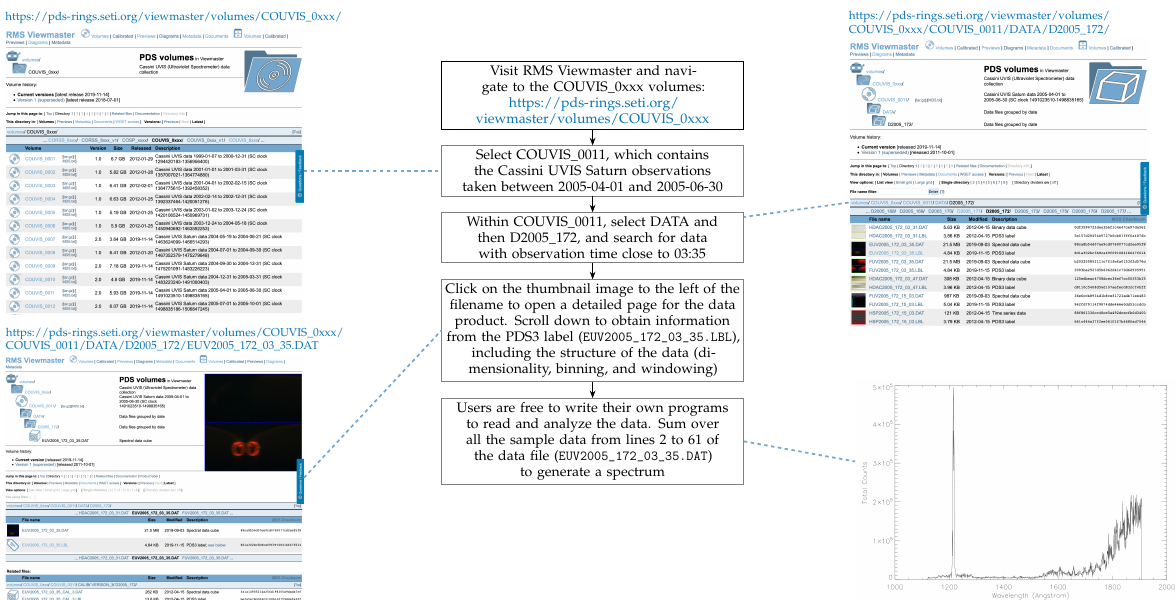
Figure 9. Step-by-step instructions on how to find and obtain UVIS data from the PDS via RMS Viewmaster for an observation of Saturn’s aurora carried out around 03:35 on day 172 of year 2005. All links in this figure were accessed on 30 October